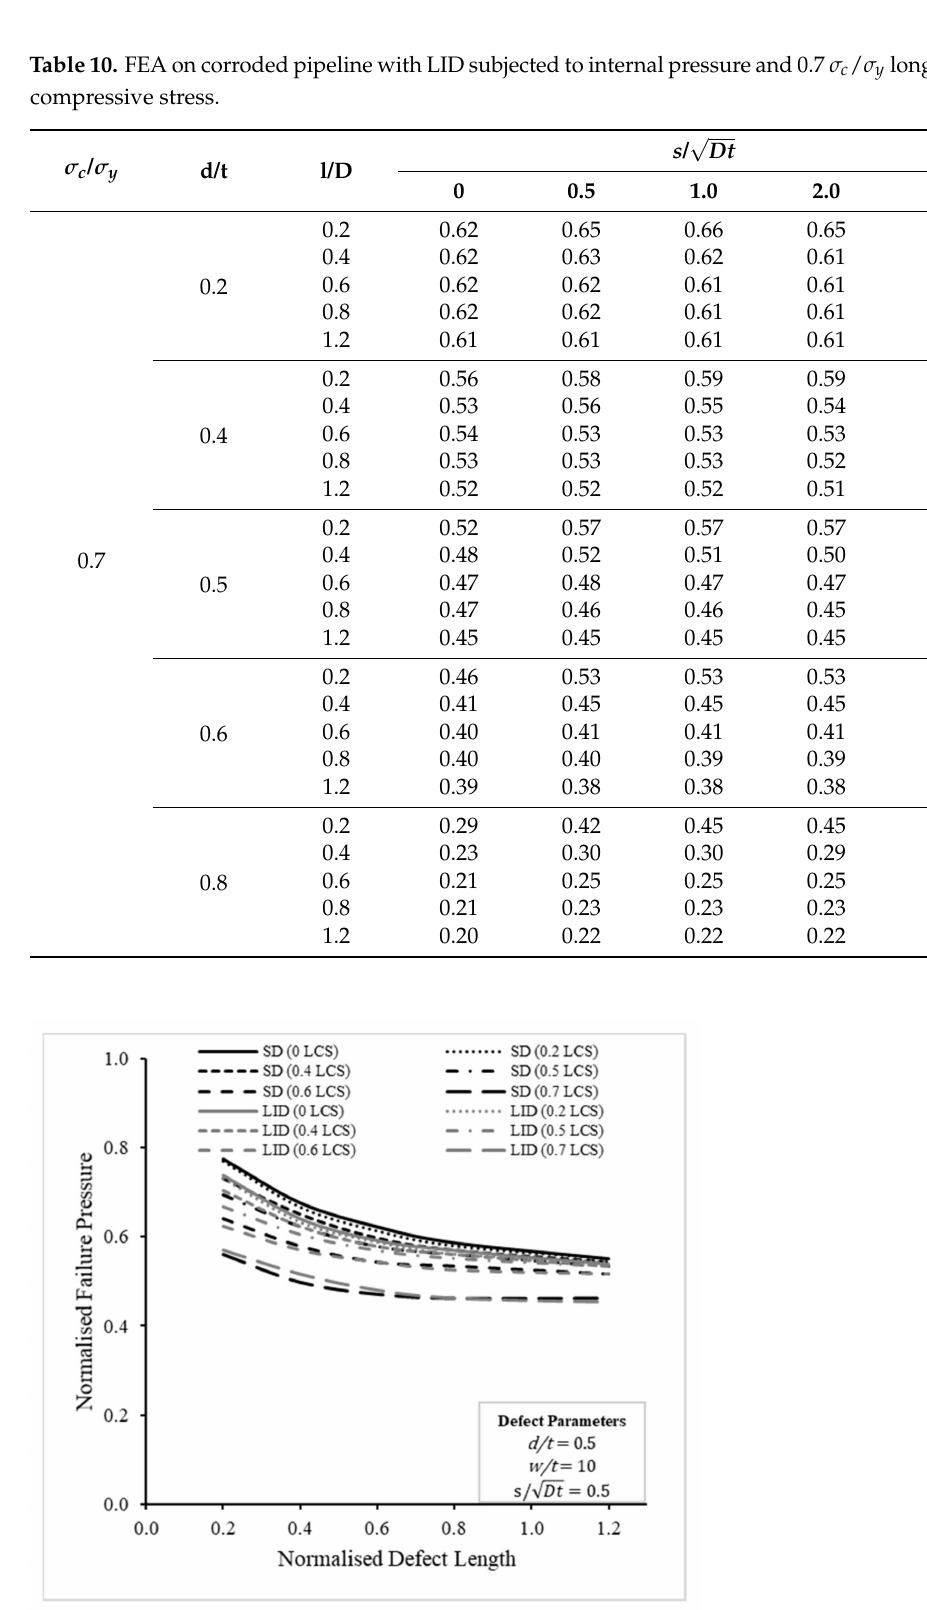
Figure 9. Single corrosion defect (SD) and LID comparison of normalised failure pressure predictions versus normalised longitudinal defect spacing across different longitudinal compressive stresses for defect spacing of